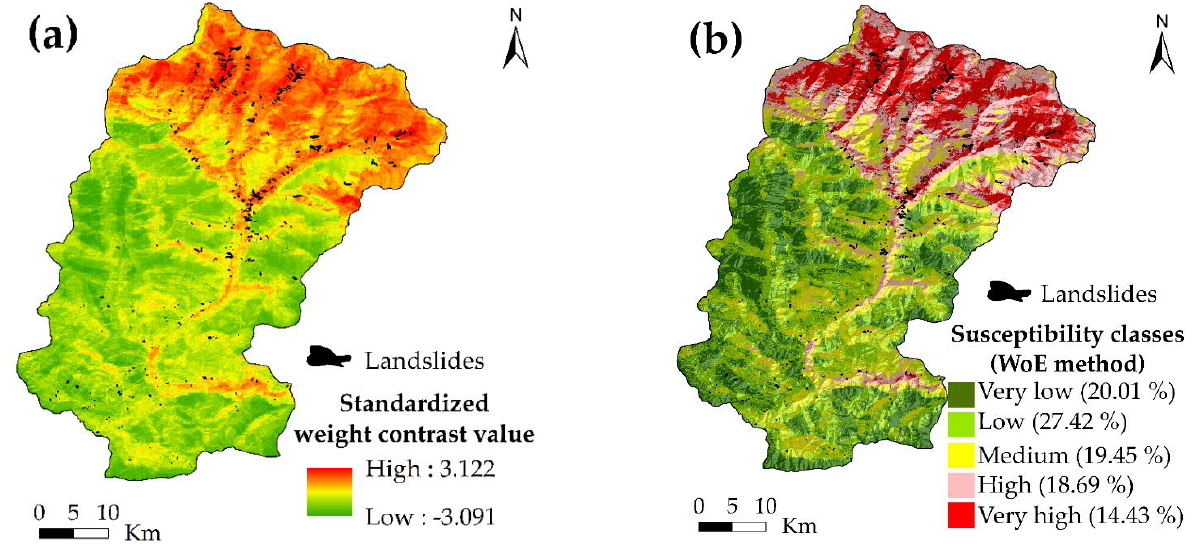
Figure 5. ( a ) Landslide susceptibility map showing the range of all standardized weight contract values, i.e., negative and positive; ( b ) the distribution of the landslide susceptibility classes.